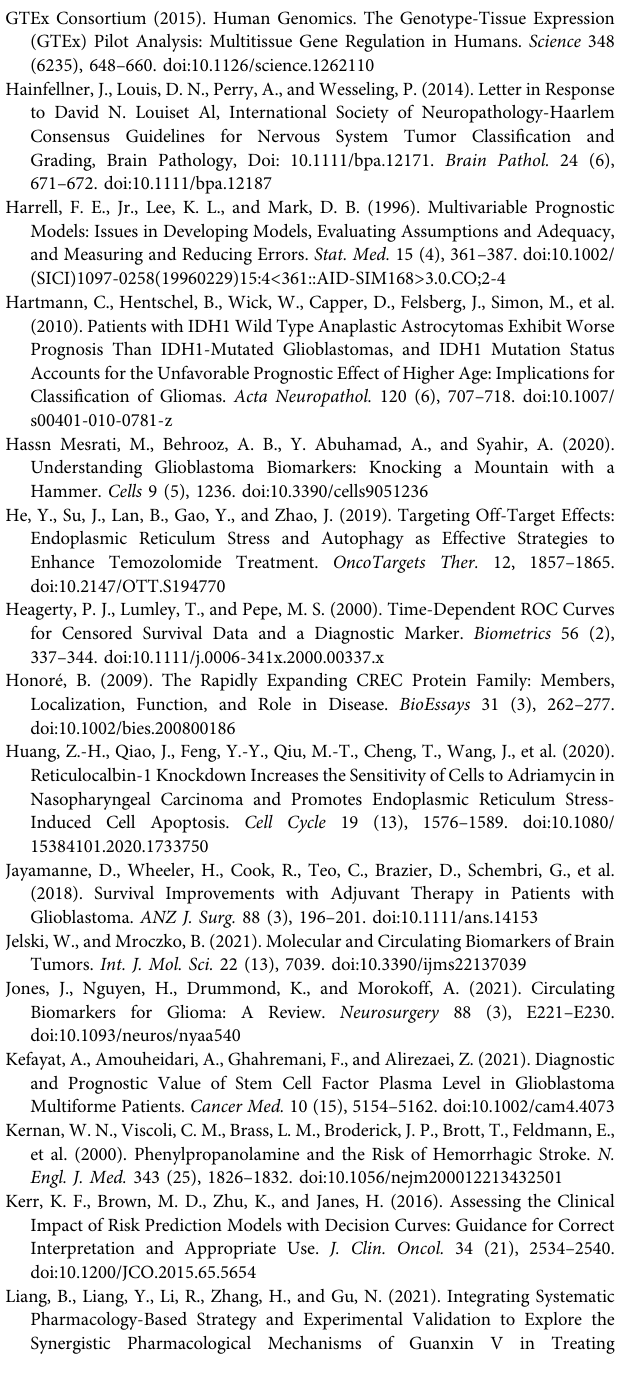
Supplementary Figure S1 | RCN1 is an independent prognostic signature compared with others. Different potential prognostic signatures were